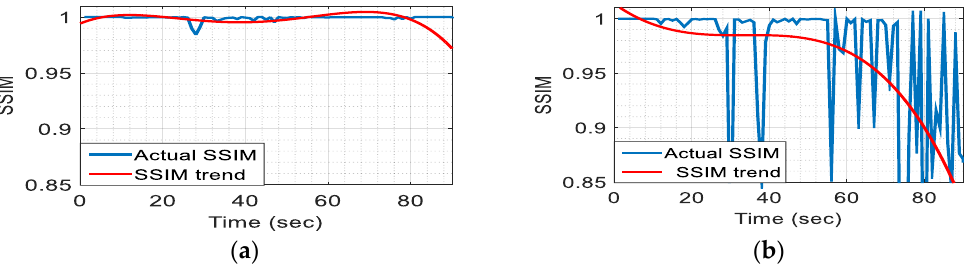
Figure 12. SSIM: ( a ) Full image and ( b ) partitioned image.